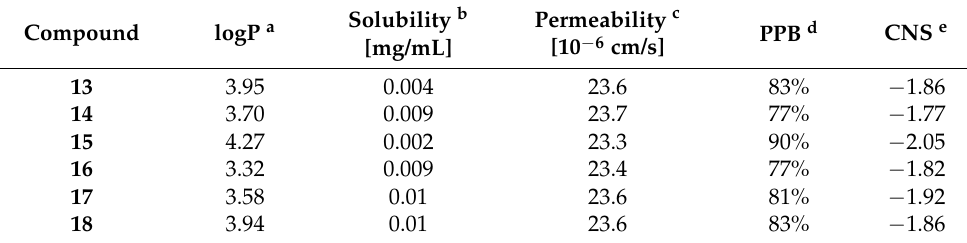
Table 1. ADME properties of the oxime derivatives 13 – 18